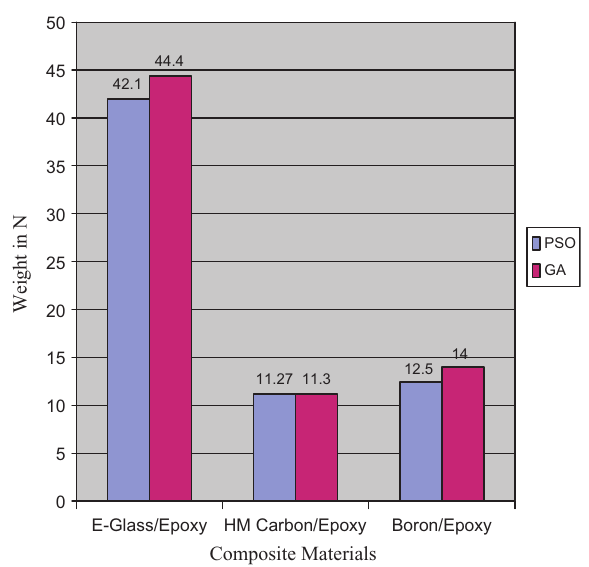
Figure 11. Comparisons of PSA results with GA results